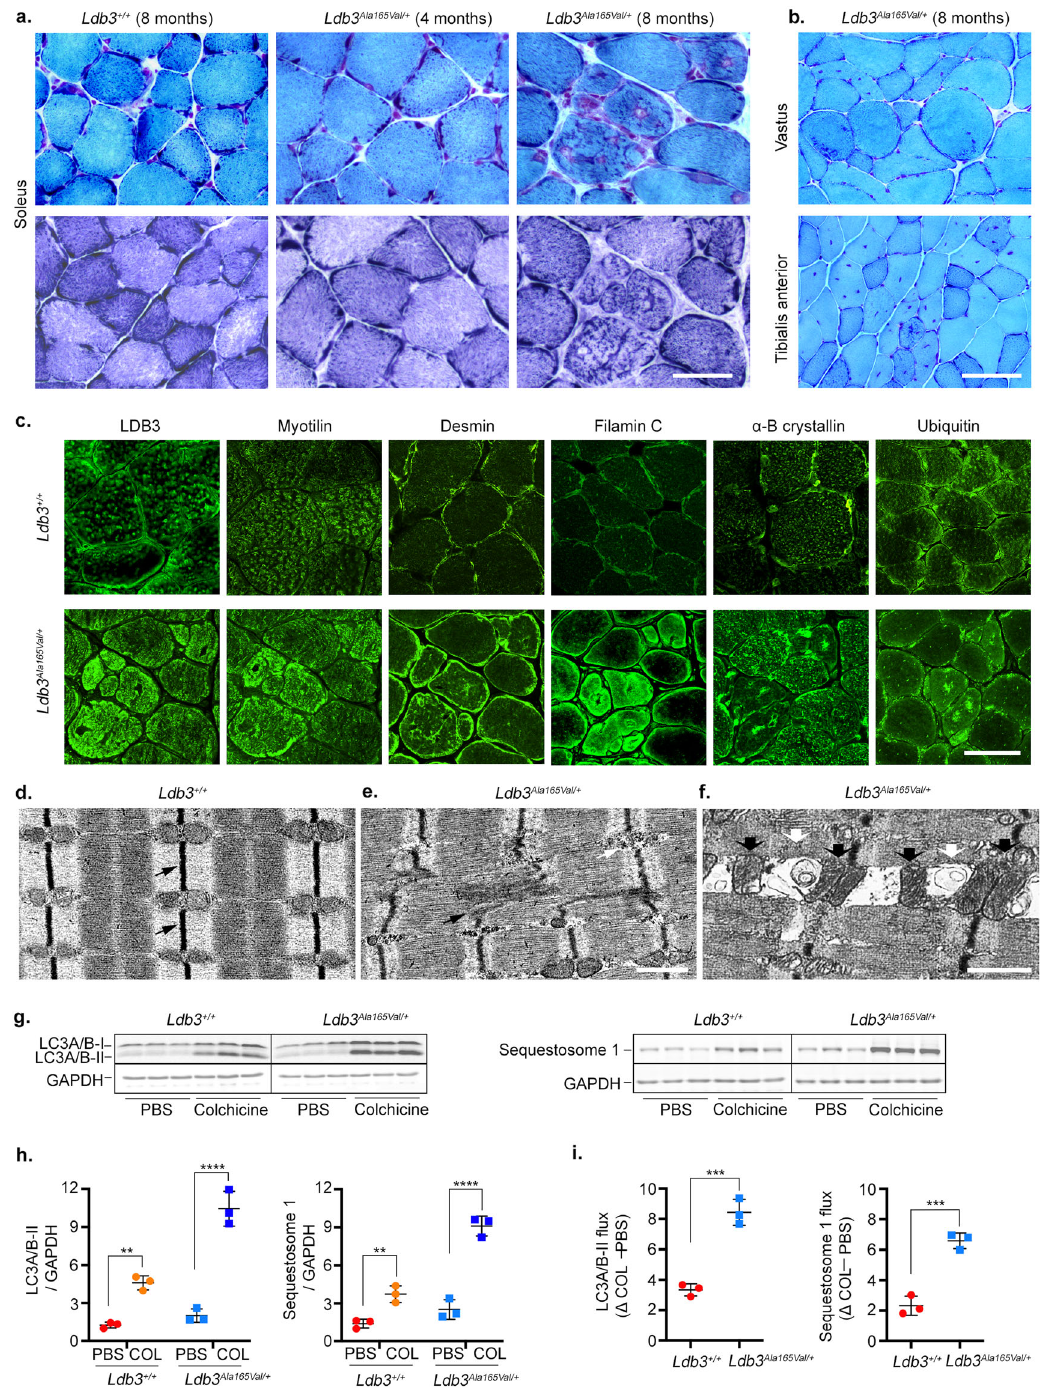
fi lamin C crosslinks, which are degraded through the conserved tension-induced chaperone-assisted selective autophagy (CASA) littermates (Fig. 3b, c). These sarcoplasmic protein aggregations were also found in the vastus muscle fi bers of MFM patients with the LDB3 p.Ala165Val mutation (Fig.